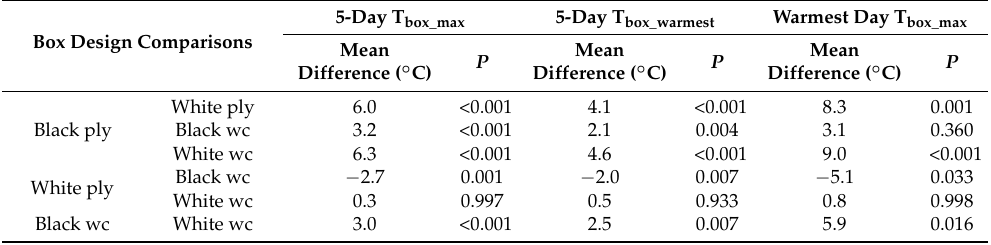
Table 2. Pairwise comparison of temperatures in front chambers (n = 4) between box designs for